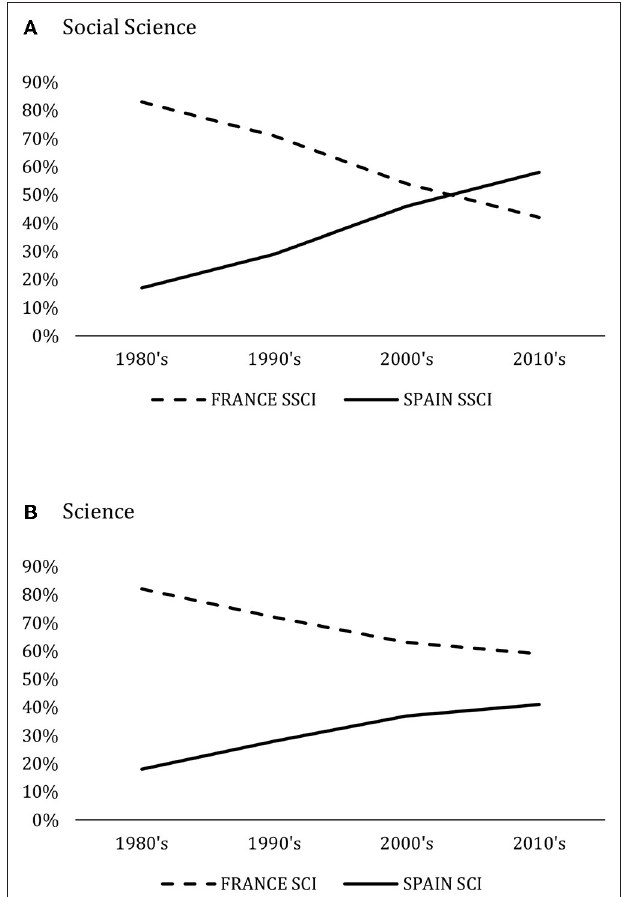
FIGURE 7 | Relative production of Spain versus France. SSCI and SCI. Data taken from the Web of Science core collection corresponding to the period